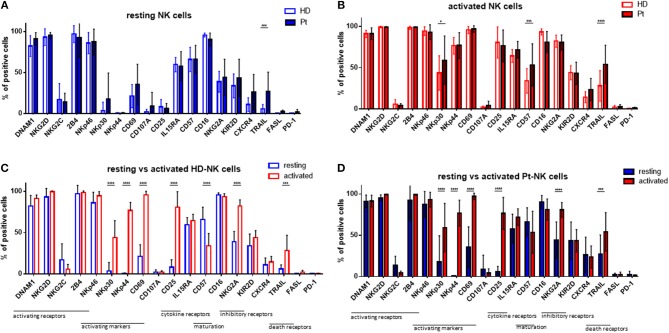
Cytokine stimulation significantly increases the expression of many NK cell activation markers. Isolated NK cells from patients and healthy donors were stained with fluorochrome-conjugated antibodies to determine surface marker expression (A) before and (B) after activation with IL-2 and Il-15. NK cell phenotypes before and after stimulation were also compared for NK cells isolated from (C) healthy donors and (D) patients. For healthy donor samples, 17 individual experiments with resting NK cells and 14 individual experiments with activated NK cells were performed (n = 14–17). For patient samples, 14 individual experiments with resting NK cells and 15 individual experiments with 7 days cytokine activated NK cells were performed (n = 14–15) Statistical analysis with two-way ANOVA + Sidak's multiple comparison: *p < 0.05, **p < 0.01, ***p < 0.001, ****p < 0.0001.